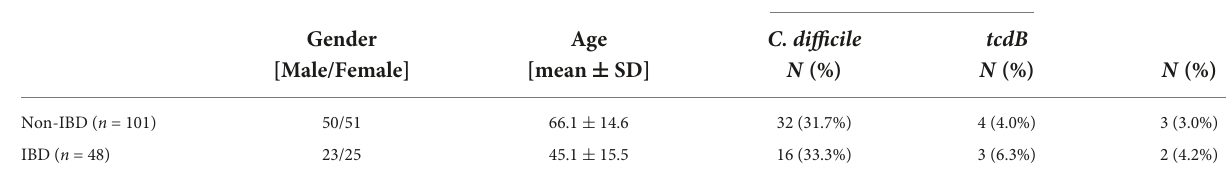
TABLE 1 Study cohort characteristics and Clostridioides difficile